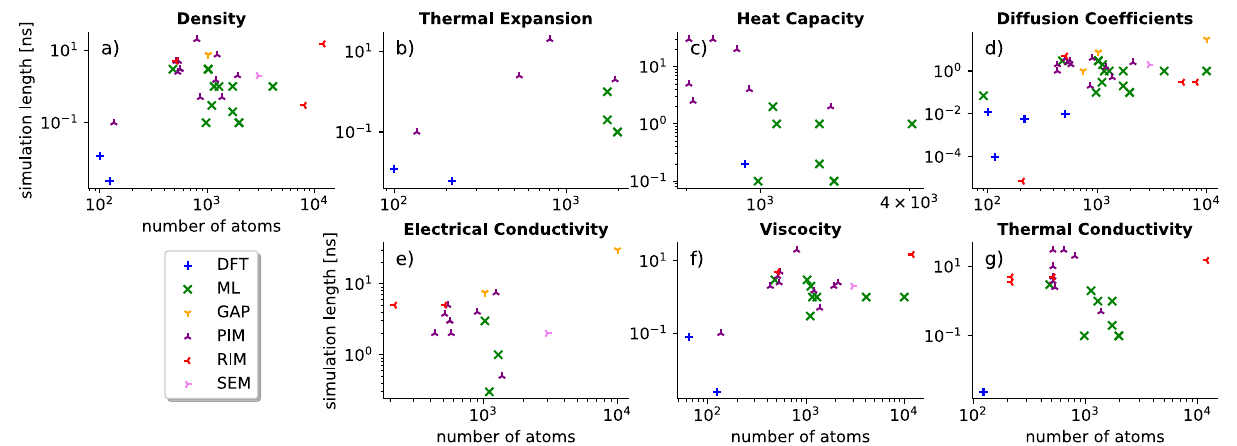
Fig. 2 Thermophysical properties extracted from reviewed articles. Colors and symbols differentiate between computational methods used in the studies (see legend in left bottom panel). For seven thermophysical properties ( a – g ), the number of atoms and the total simulation lengths are